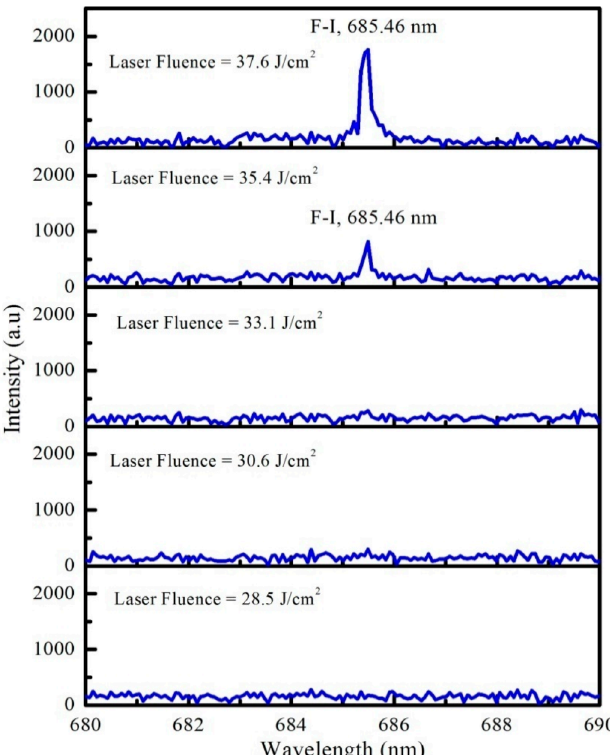
Figure 4. Emission line spectra in the region of interest showing the appearance of the F-I line at 685.46 nm from topaz plasma induced at fluence values in the range of 28.5–37.5 J · cm − 2